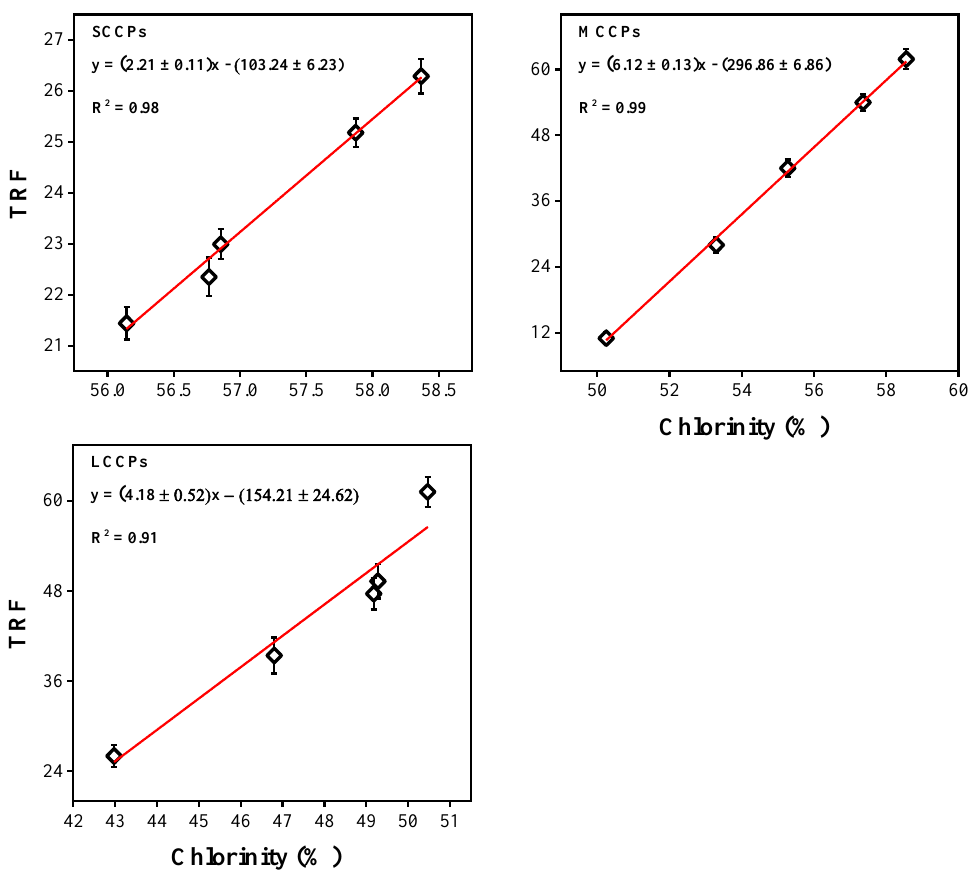
Figure 2. Calculated standard curves between the total response factor (TRF) and chlorinity (%) of CPs using standard CP mixtures.